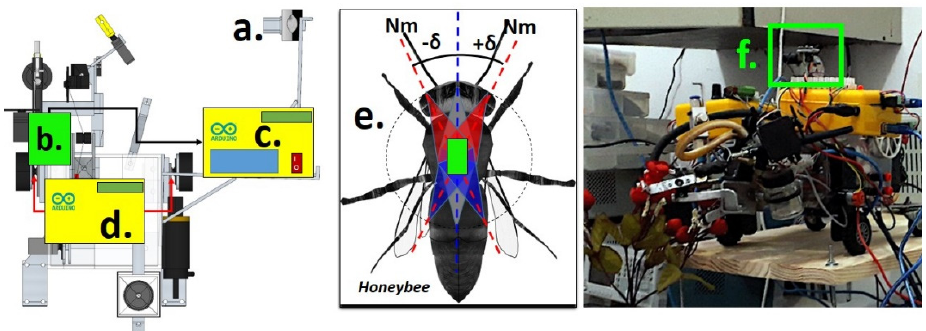
Figure 3. Bioinspired positioning method: ( a ) Lateral camera; ( b ) Geomagnetic sensor module; ( c ) Rover’s signal acquisition module; ( d ) Rover’s motion control module; ( e ) Illustration of the Magnetic detection through the abdomen of Honeybee in the green rectangle; ( f ) Geomagnetic sensor module implemented in rover.